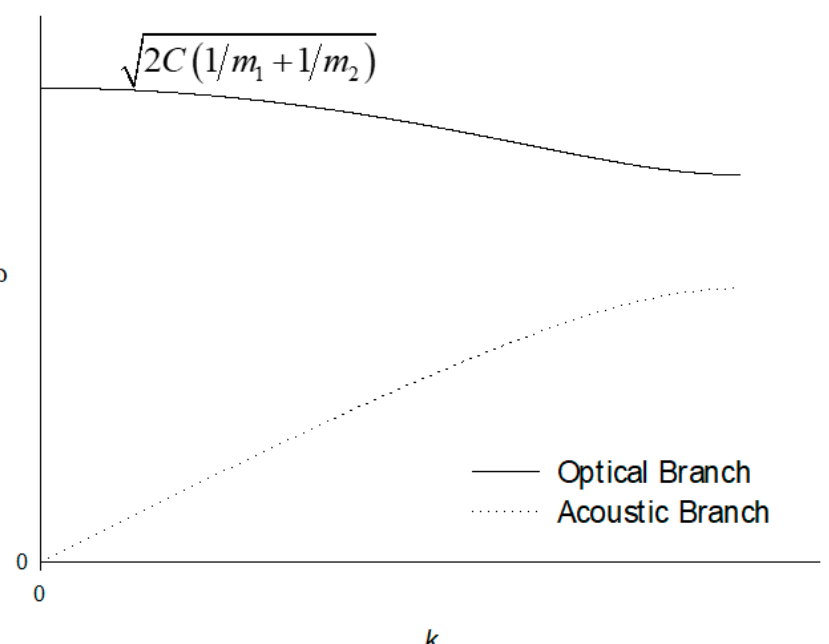
Figure 2. Optical and acoustic branches of the dispersion relation for a diatomic linear lattice. Here, m 1 > m 2 , and the branch for m 2 is above m 1 .